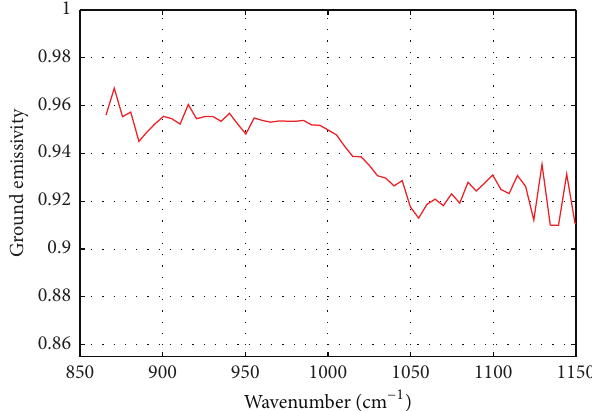
Figure 18: Mean ground spectral emissivity retrieved through the